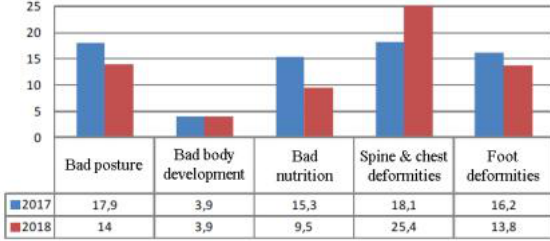
Figure 4. Most common pathological conditions identified in medical examinations of primary school students (Source: Institute of Public Health in Skopje [14])